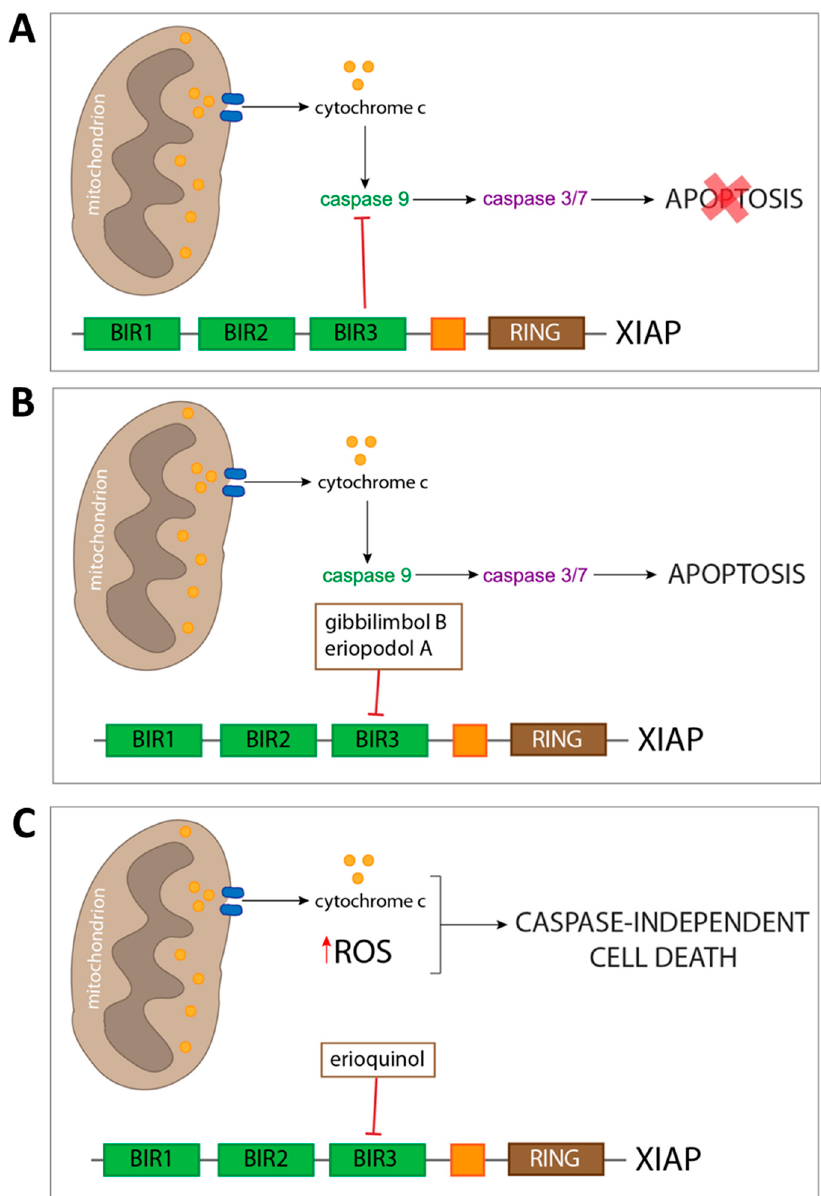
Figure 13. Schematic picture depicting cell death mechanisms of Piper genus-derived compounds. Escape of both intrinsic and extrinsic apoptosis is a common feature of cancer cells. ( A ) This hallmark is often carried out by overexpressing anti-apoptotic proteins, such as X-linked inhibitor of apoptosis protein (XIAP), which prevents the execution of apoptosis by binding of its baculovirus IAP repeat (BIR) 3 domain to already active initiator caspase 9. In order to counteract this resistance to cell death, several cancer pharmacological therapies have the aim of removing the ‘molecular brakes’ to apoptosis sensitising cancer cell to undergo loss of viability. The approach we described includes the use of three compounds from Piper genus plants which were predicted to bind XIAP-BIR3 domain. ( B ) Two of the compounds (gibbilimbol B and eriopodol A) were shown to induce a classical pro-apoptotic response, including mitochondrial outer membrane polarisation, release of cytochrome c, and subsequent activation of both initiator and effector caspases. ( C ) Despites triggering a similar response at the mitochondria level, erioquinol does not act through the apoptotic machinery, and results in a caspase-independent cell death characterised by cytoplasmic reactive oxygen species (ROS)